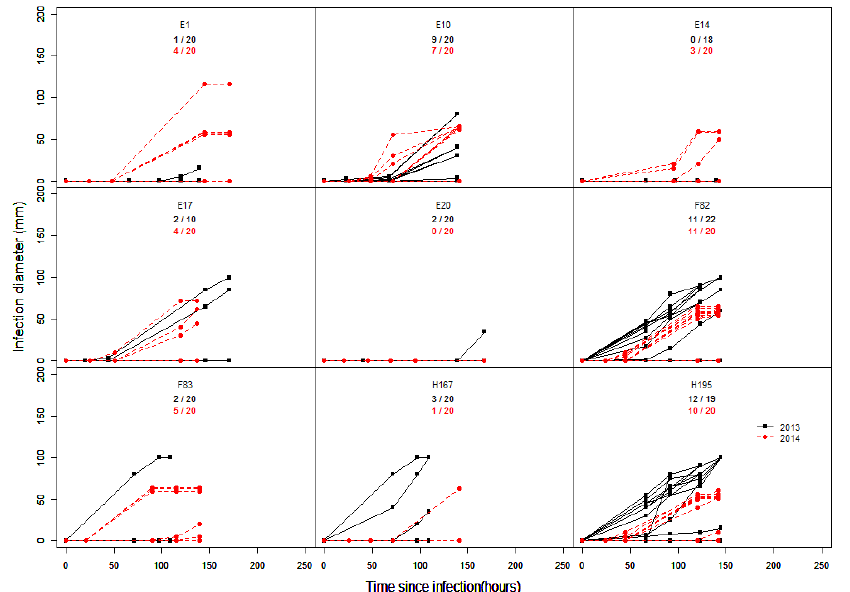
Figure 4. Development of lesion diameter (mm) in infected fruit. Intact fruit were inoculated with a droplet of 10 µL M. laxa at 10 5 conidia mL −1 concentration over two years. Each curve represents an infected fruit out of 20 inoculated (infected/total inoculated) fruits for nine genotypes (black curves: 2013; red curves: 2014). Inoculated fruit were incubated in clear plastic boxes with maximized relative humidity for seven days.